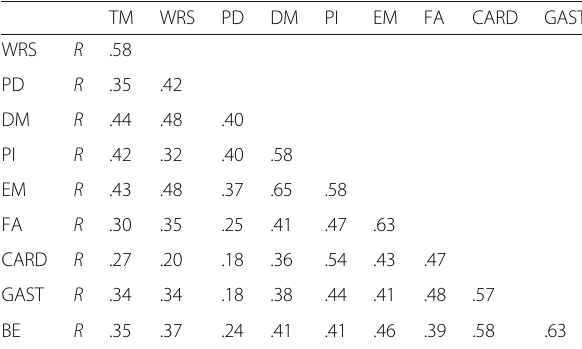
Table 4 Correlations between the modified Teacher Stress Inventory